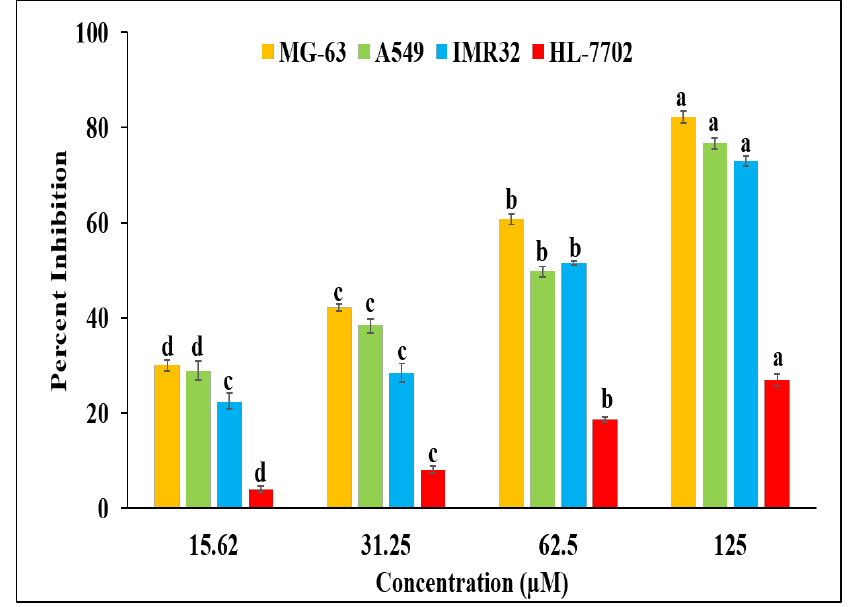
Figure 8. Cytotoxic potential of BDCe fraction obtained from Obea of O. bracteata on MG-63, A549, IMR32, and HL-7702 cells after 24 h of treatment. Values are expressed as Mean ± SE at a level of significance p ≤ 0.05. Data labels with different letters represent significant differences among them.